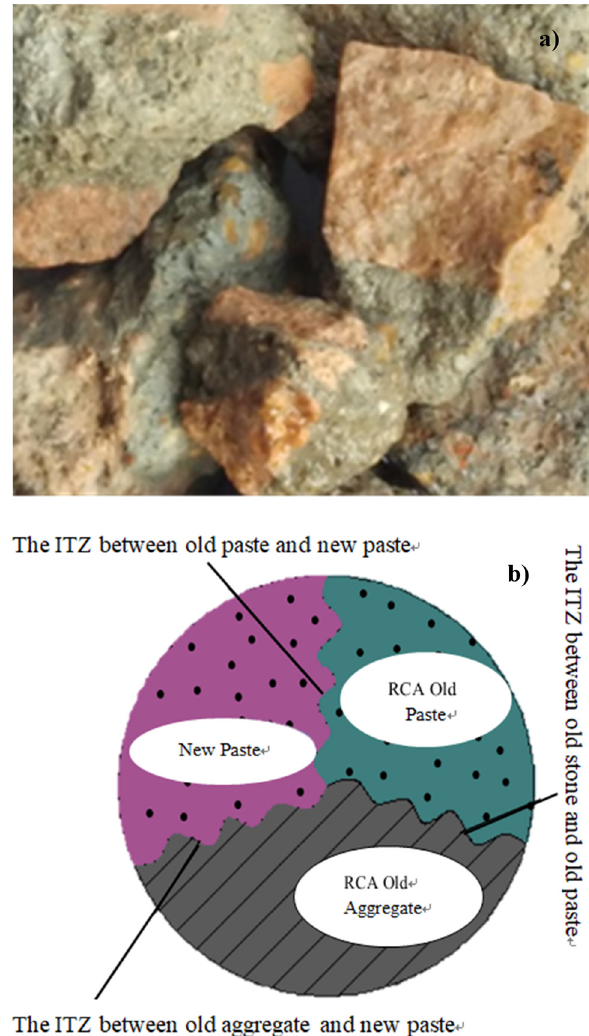
Figure 1: Recycled aggregate ( a ) and multiple ITZ illustration of recycled coarse aggregate ( b )